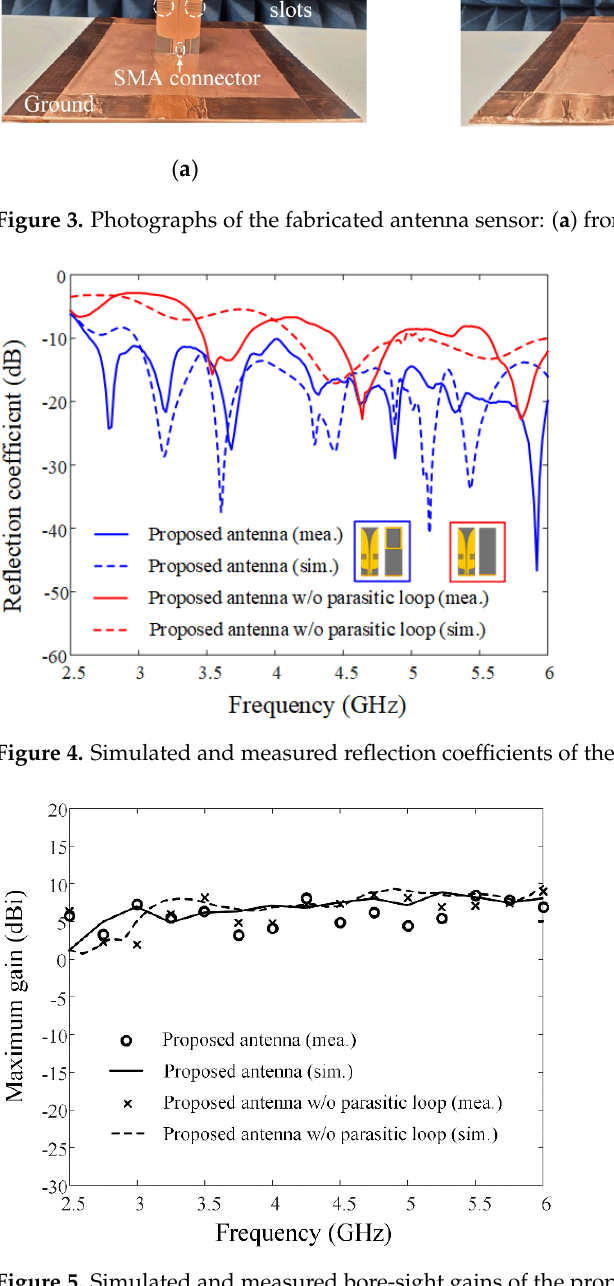
Figure 5. Simulated and measured bore-sight gains of the proposed antenna.